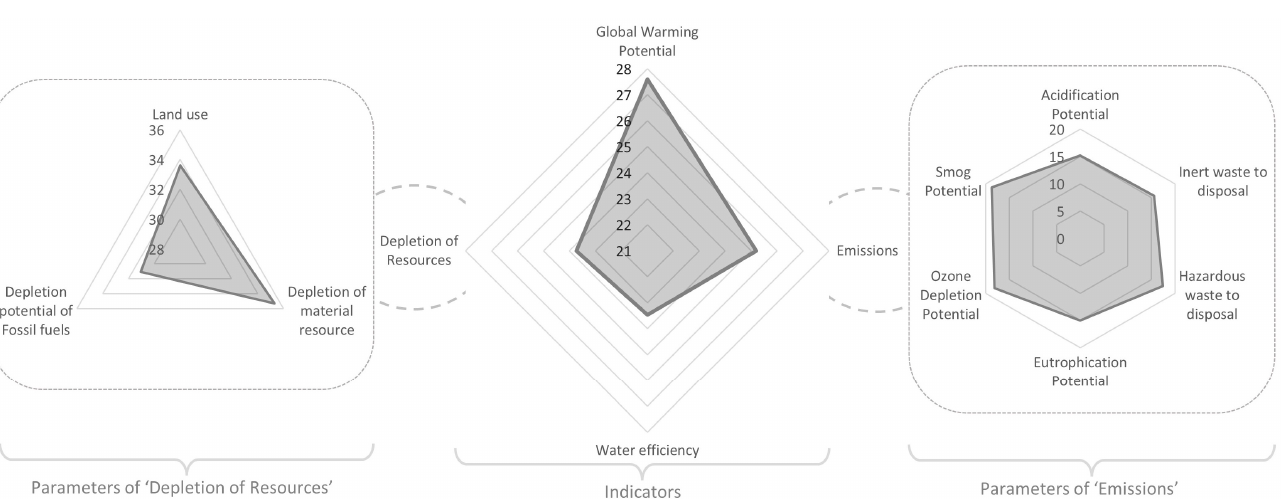
Table 4. LCIA-related calculations for structural beam.